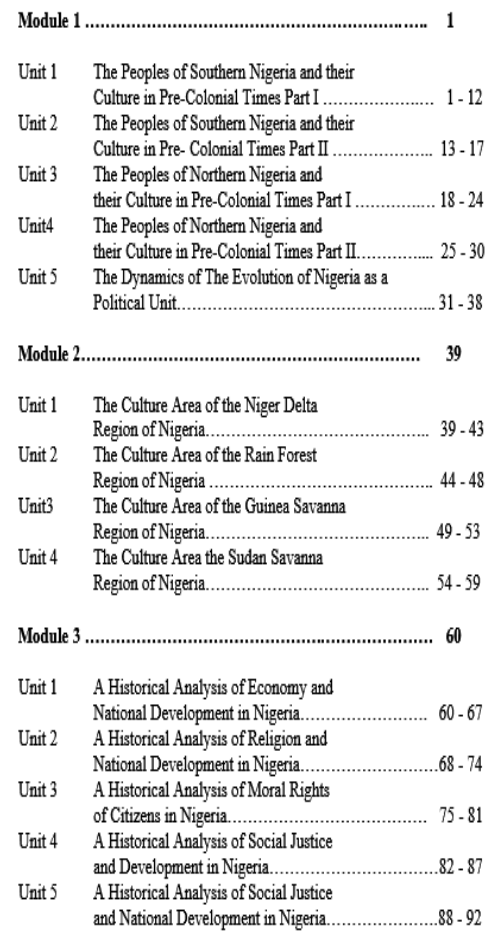
Figure 1. (GST 201-Nigerian Peoples and Culture 2008, p. iii).